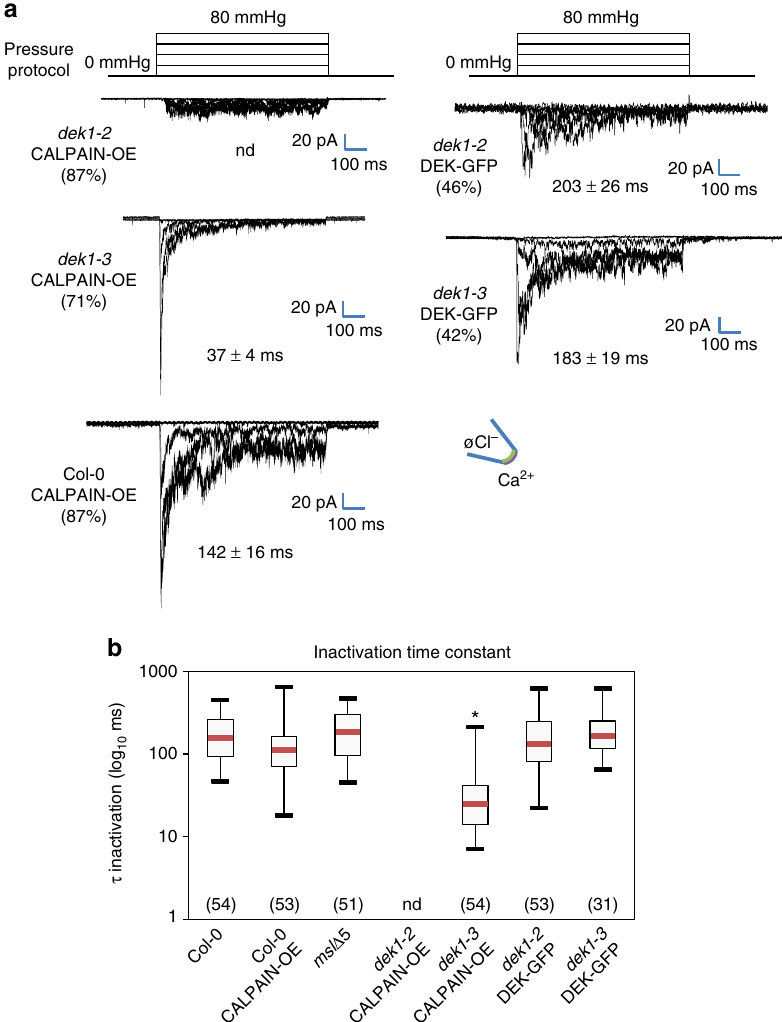
Fig. 3 RMA activation depends on the trans-membrane region of the essential DEK1 protein. a Mechanosensitive current kinetics in response to pulse pressure (as illustrated) in dek1-2 CALPAIN-OE, dek1-3 CALPAIN-OE, Col-0 CALPAIN-OE, dek1-2 DEK-GFP and dek1-3 DEK-GFP. Time constants are means ± SE ( n = 6); b Inactivation times are fi tted with an exponential function, and time constants ( τ inact ) are represented in a box plot distribution for different lines. Number in brackets represent the number of time constants. *signi fi cantly different from Col-0 line, Anova on ranks ( P < 0.05). For all experiments the membrane potential was held at − 196 mV. Ionic conditions are described in the Methods